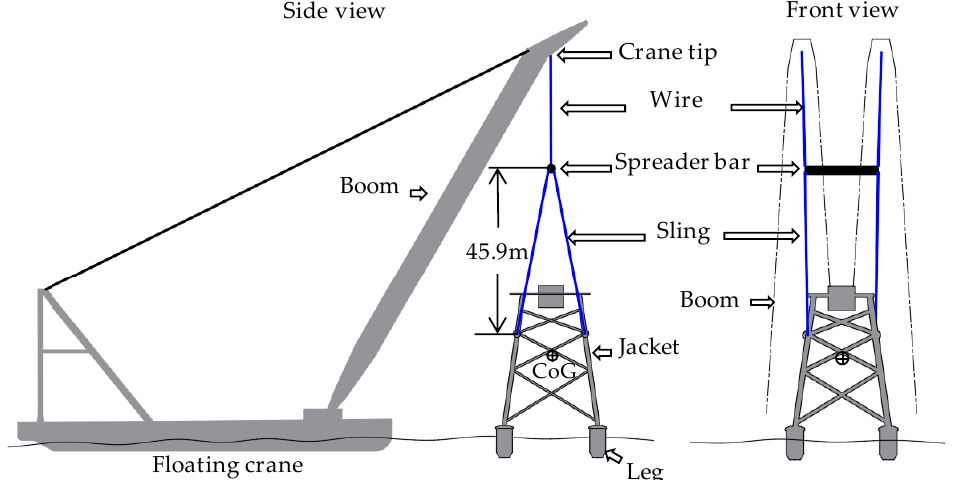
Figure 2. General sketch of the lowering system in an arbitrary location.